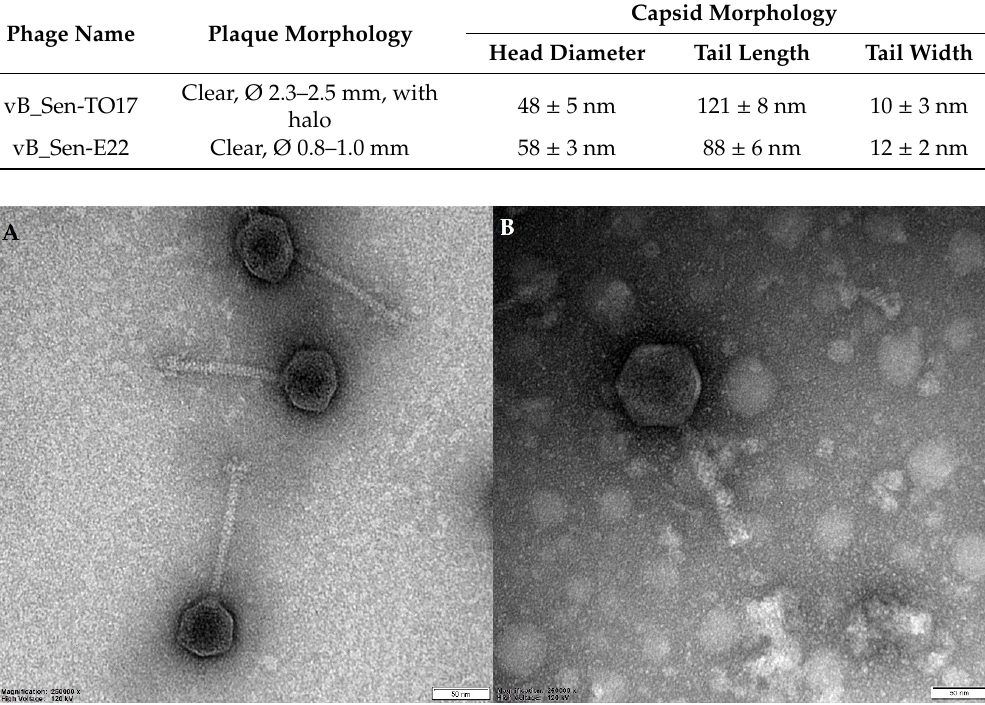
Figure 2. Electron micrographs of virions of vB_Sen-TO17 ( A ) and vB_Sen-E22 ( B ). Size bars (representing 50 nm) are shown at the bottom of each micrograph.